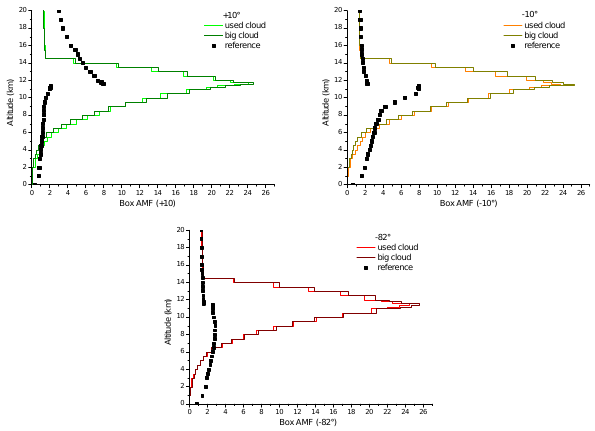
Fig. A1. Box AMF for the cloud top height of 14.5km and a cloud extinction coefficient of 13km − 1 , for both the small cloud we used and a Figure A1. Box AMF for the CTH of 14.5km and a CE coefficient the bigger (more realistic) cloud. The difference between the two Box-AMFs is small. In addition the Box AMFs for the reference case are of 13km − 1 , for both the small cloud we used and a bigger (more shown. realistic) cloud. The difference between the two box AMFs is small. In addition the Box AMFs for the reference case are